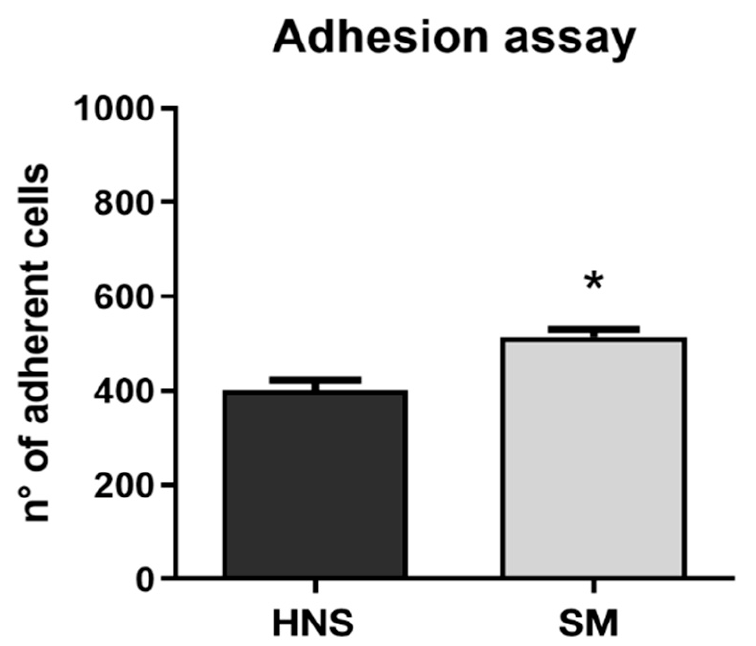
Figure 1. Cell adhesion was evaluated on all samples at 12 min. The level of cell adhesion was measured by counting the number of adherent cells for each sample. Values represent mean ± SEM. The symbol (*) indicates the statistical significance vs. HNS surface considering a p -value < 0.05.